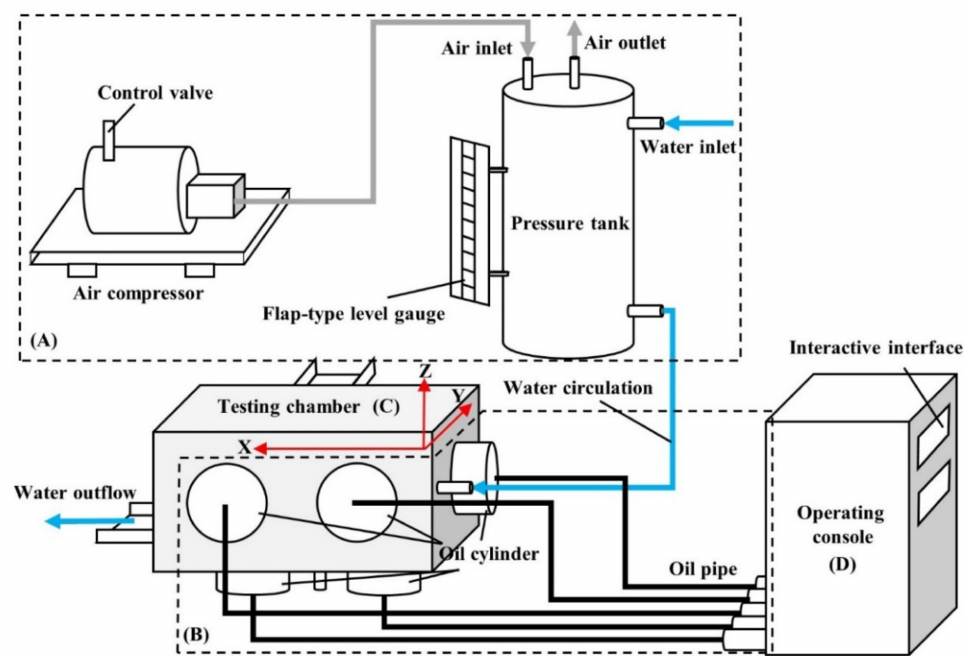
Figure 1. Schematic layout of the existing test